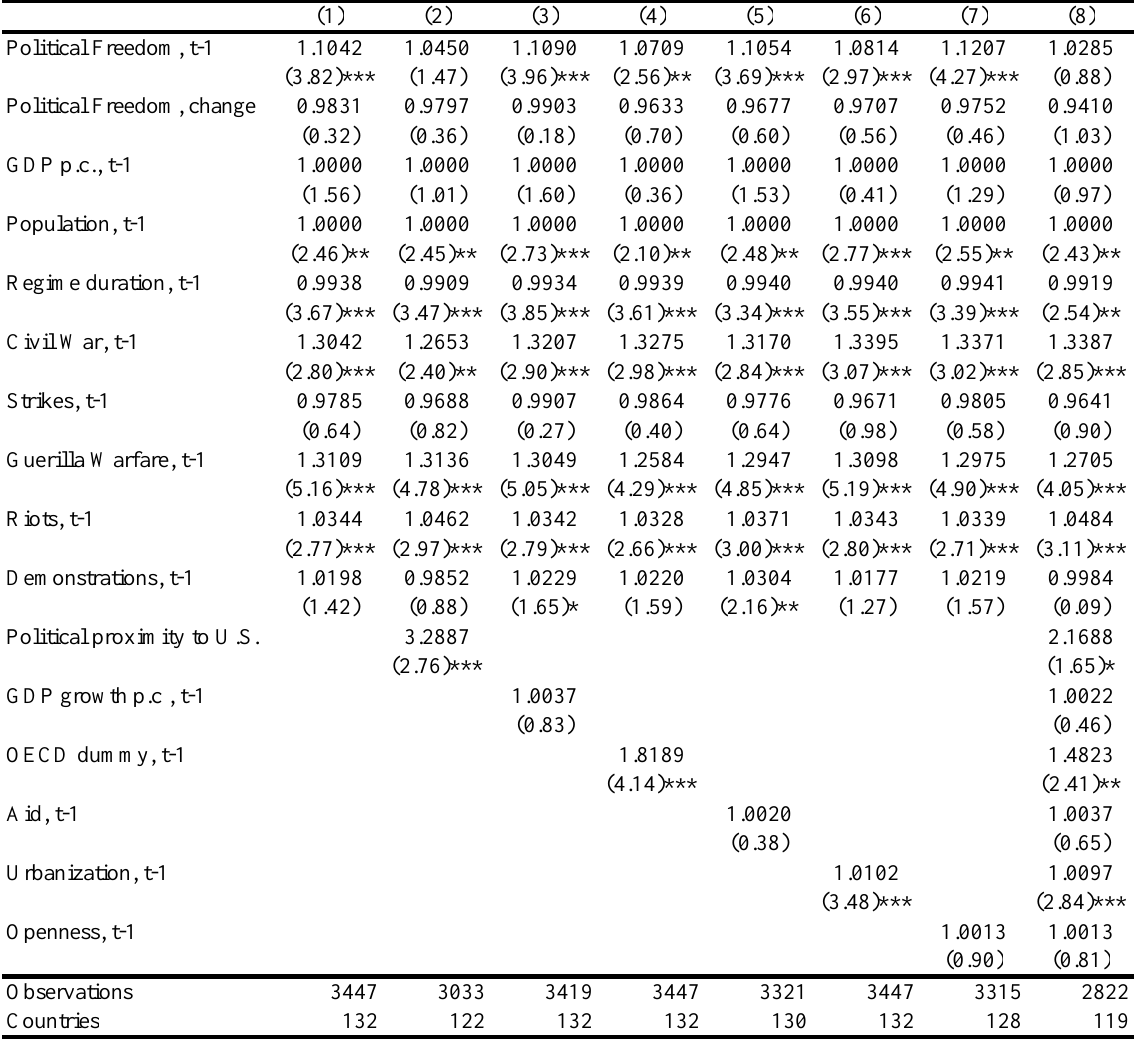
Table 3: Determinants of International Terror Events (Absolute Number), Developing and Developed Countries, 1972-2003, Fixed-Effects Negative Binomial Panel